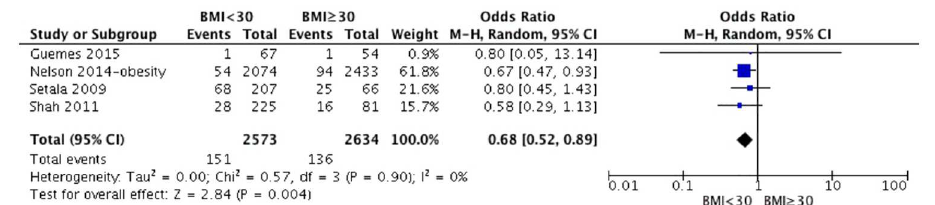
Fig 3. Correlations between BMI and infections.